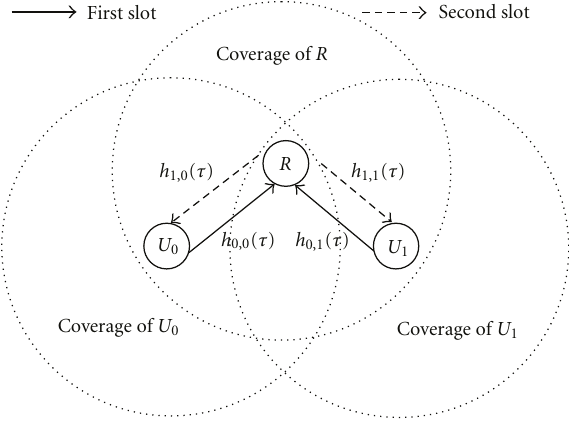
Figure 1: Network